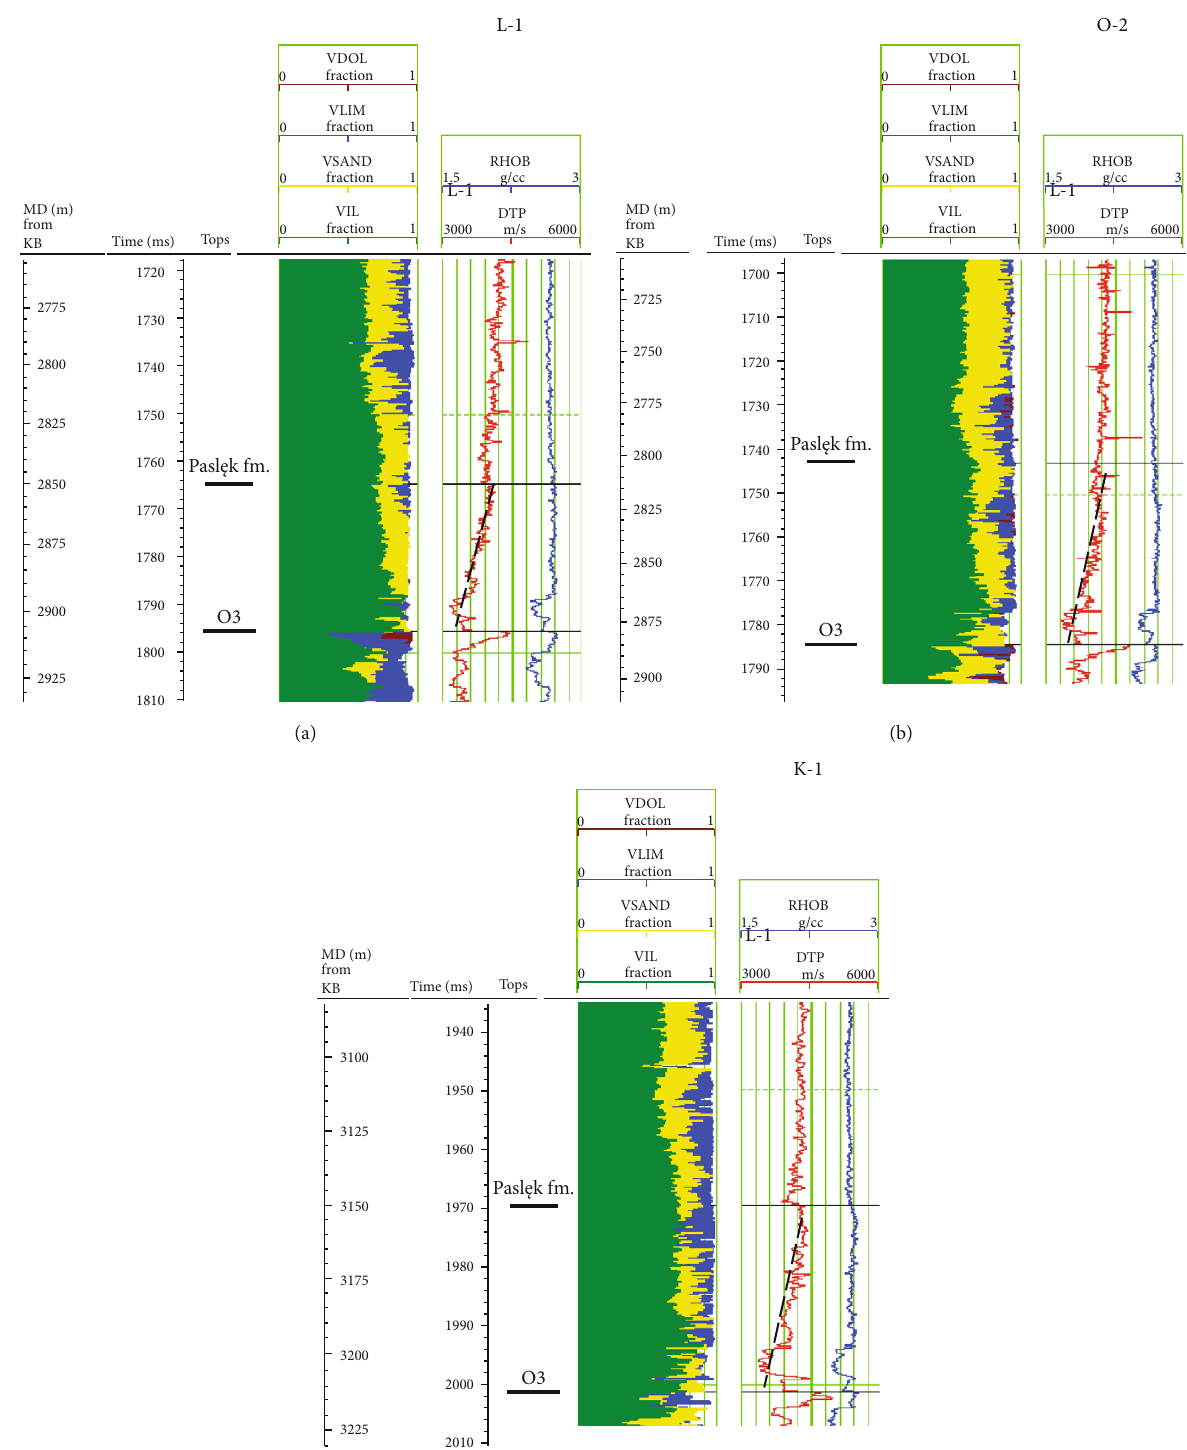
Figure 14: Well logs representing sonic (DTP) and density logs (RHOB) and lithological information for wells L-1, O-2, and K-1. Pas łę k fm: the top of the Pas łę k Formation; Prabuty mudstone: O3. Dashed black line approximates the linear character of velocity of the Pas łę k Formation; dashed red line indicates the increase in volumetric clay mineral